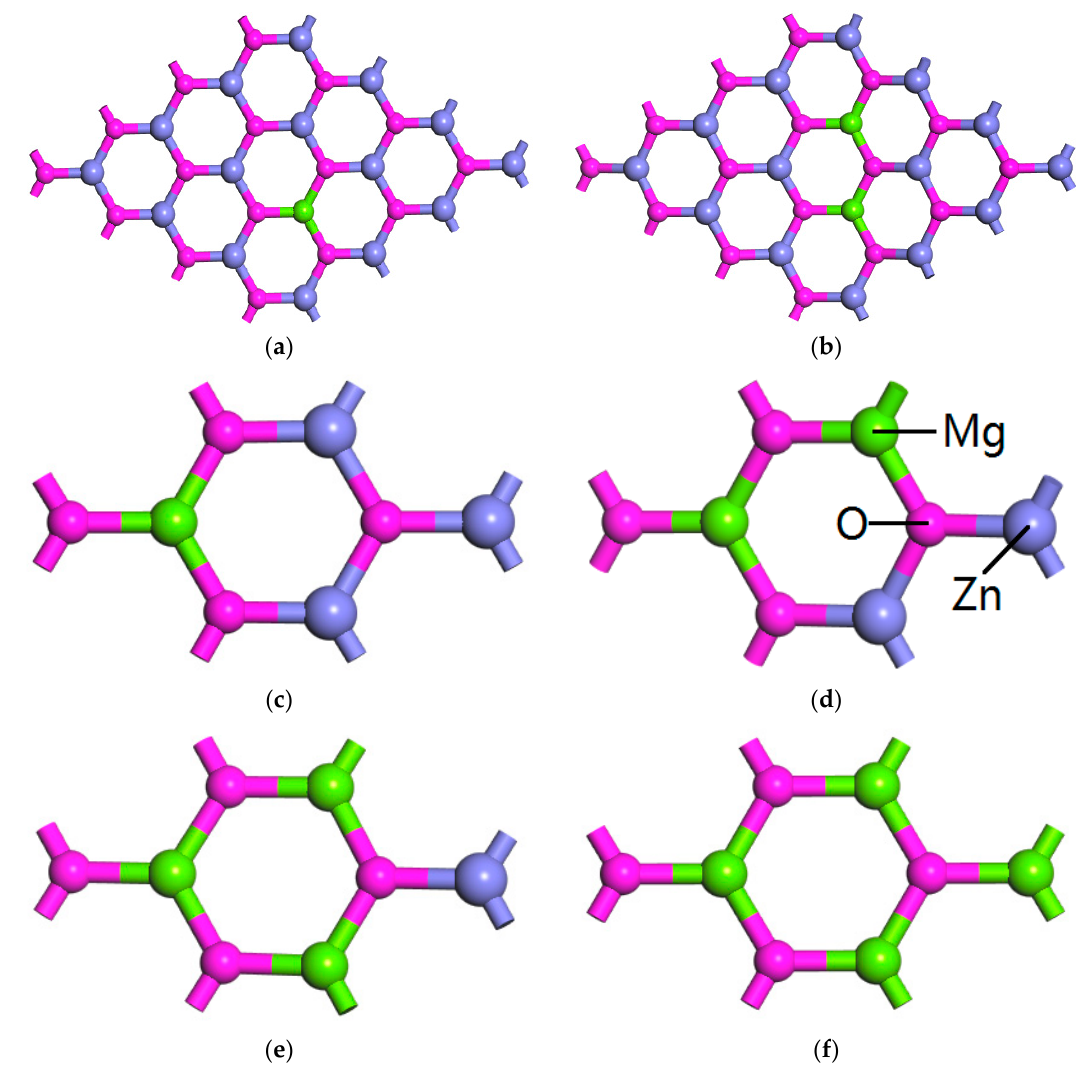
Figure 2. The relaxed structure of Mg x Zn 1 − x O monolayer ( a ) x = 0.0625; ( b ) x = 0.125; ( c ) x = 0.25; ( d ) x = 0.5; ( e ) x = 0.75; ( f ) x = 1.